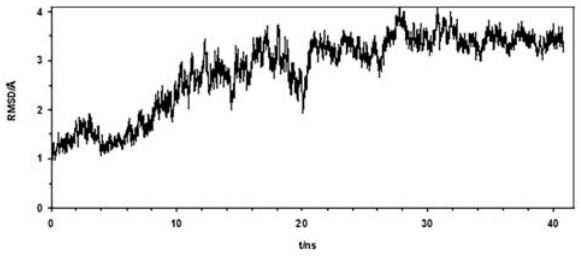
Fig. 3. Root Mean Square Deviations (RMSD) of the DPP III obtai- ned during 40.8 ns of MD simulation, in complex with inhibitor 1 .